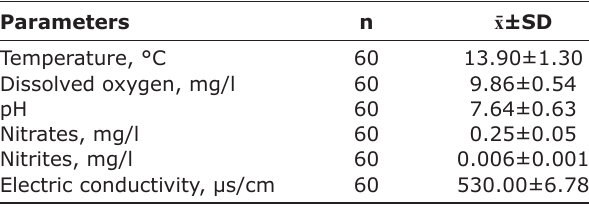
Table-2: Water parameters in the recirculation system for rainbow trout ( Oncorhynchus mykiss W.) farming.